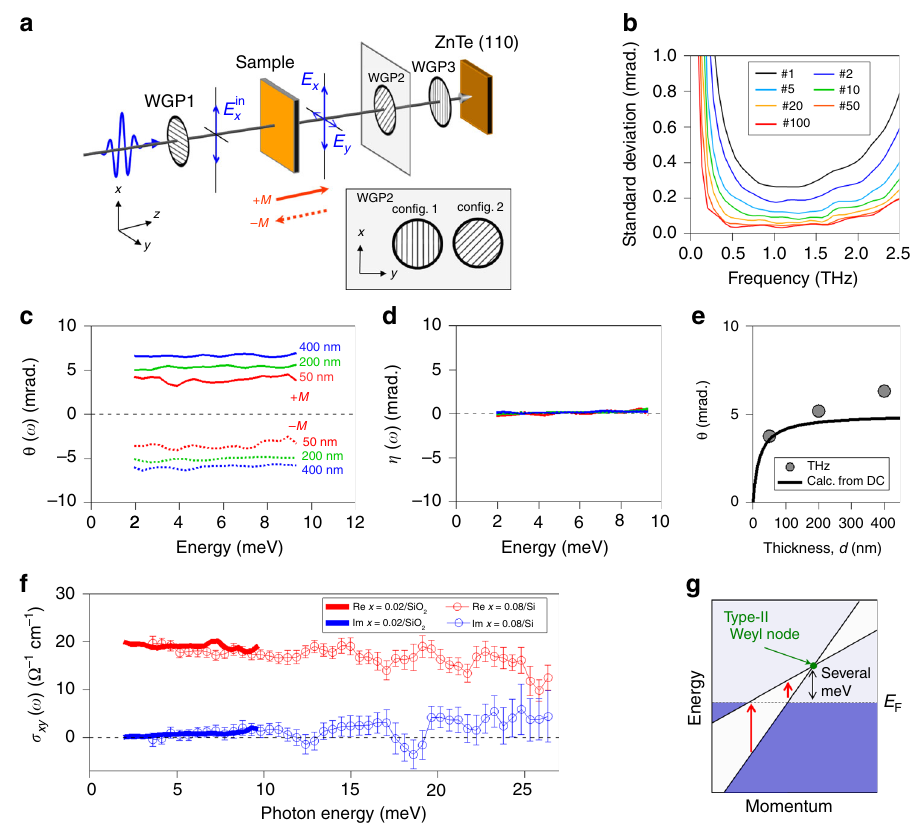
Fig. 2 THz anomalous Hall effect at room temperature with polarization-resolved spectroscopy. a A schematic of our polarization-resolved measurement setup. WGP wire-grid polarizer. b Frequency dependence of the precision of the polarization rotation angle in this measurement evaluated by the standard deviation of the polarization rotation angle. The precision can be more improved with using a larger number (#) of data sets. For example, the precision for 20 data sets (#20) can be as small as several tens of μ rad between 0.5 and 2.0 THz (See details in text and Methods). c , d The rotation-angle and ellipticity-angle spectra in Mn 3 + x Sn 1 − x fi lms ( x = 0.02) with different fi lm thicknesses at room temperature. The broken curves correspond to the data with a fl ipped sample for the opposite magnetization vector. e Filled circles are the averaged rotation angle as a function of the fi lm thickness. The solid line is the calculation of Eq. (1) fi xed the DC longitudinal and Hall conductivity for 200-nm-thick sample. f The real- and imaginary-part Hall conductivity spectra for Mn 3 + x Sn 1 − x fi lms. The solid curves show the low-frequency THz-TDS for x = 0.02 on a SiO 2 substrate and the open circles show the broadband spectrum for x = 0.08 on a Si substrate. g A schematic of interband transition across the type-II Weyl nodes. The error bars in f indicate the standard deviations for the statistical fl uctuation after repeating the corresponds to the reverse of the cluster octupole moment. Upon fl ipping, the signs of the rotation angle are reversed. The fi lled circles in Fig. 2e show the thickness dependence of θ ( ω ) averaged